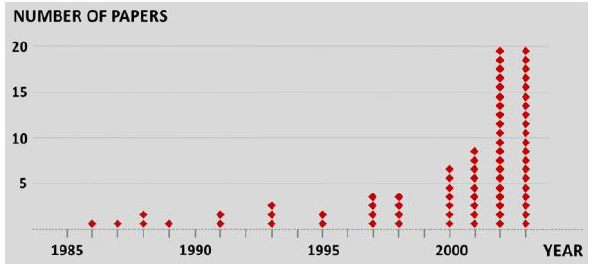
Table 1. Scholarly papers on the problem of surface parameterization published per year in the period 1985-2003. Survey by (Floater-Hoffman, 2006: